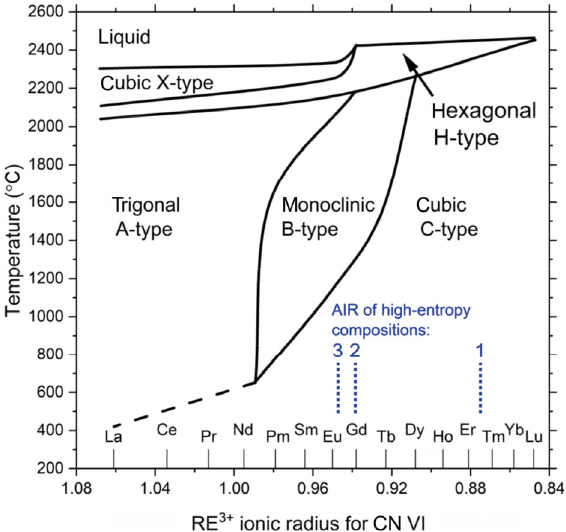
Fig. 1 Schematic diagram of polymorphic transformations for single-RE RE 2 O 3 as a function of temperature and RE ionic radius for CN VI [7,26]. The relative horizontal position of the AIR of the high-entropy compositions 1 (Lu,Y,Ho,Yb,Er) 2 O 3 , 2 (Lu,Y,Ho,Nd,La) 2 O 3 , and 3 (Lu,Y, Gd,Nd,La) 2 O 3 are indicated as the vertical dashed lines.